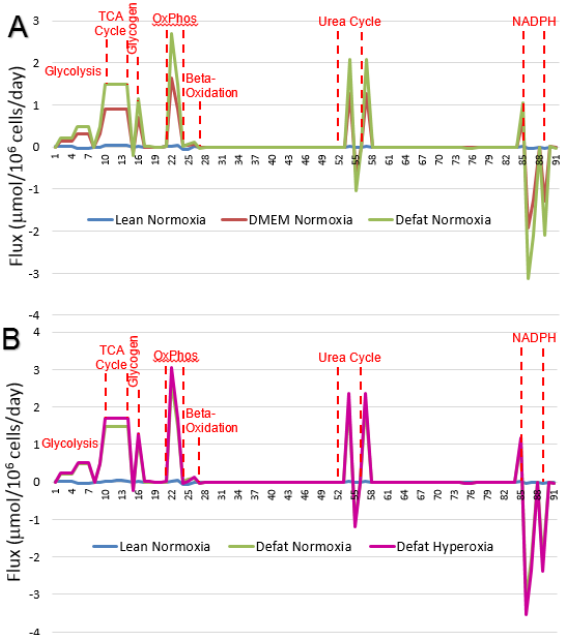
Figure 3. Effect of defatting condition on metabolic flux distribution. Numbers on horizontal axis correspond to reaction numbers shown in Table 2. Values shown are calculated using the MFA model with averaged measured fluxes in each group as input. ( A ) Fluxes for steatotic HepG2 cells during defatting under normoxic conditions (21% O 2 v/v ) in basal medium (DMEM) vs. medium supplemented with defatting agents (Defat). Lean controls are for cells that were never made steatotic; ( B ) Fluxes for steatotic HepG2 cells during defatting in medium supplemented with defatting agents under normoxic (21% O 2 v/v ) vs. hyperoxic (90% O 2 v/v ) conditions. Lean controls are for cells that were never made steatotic.